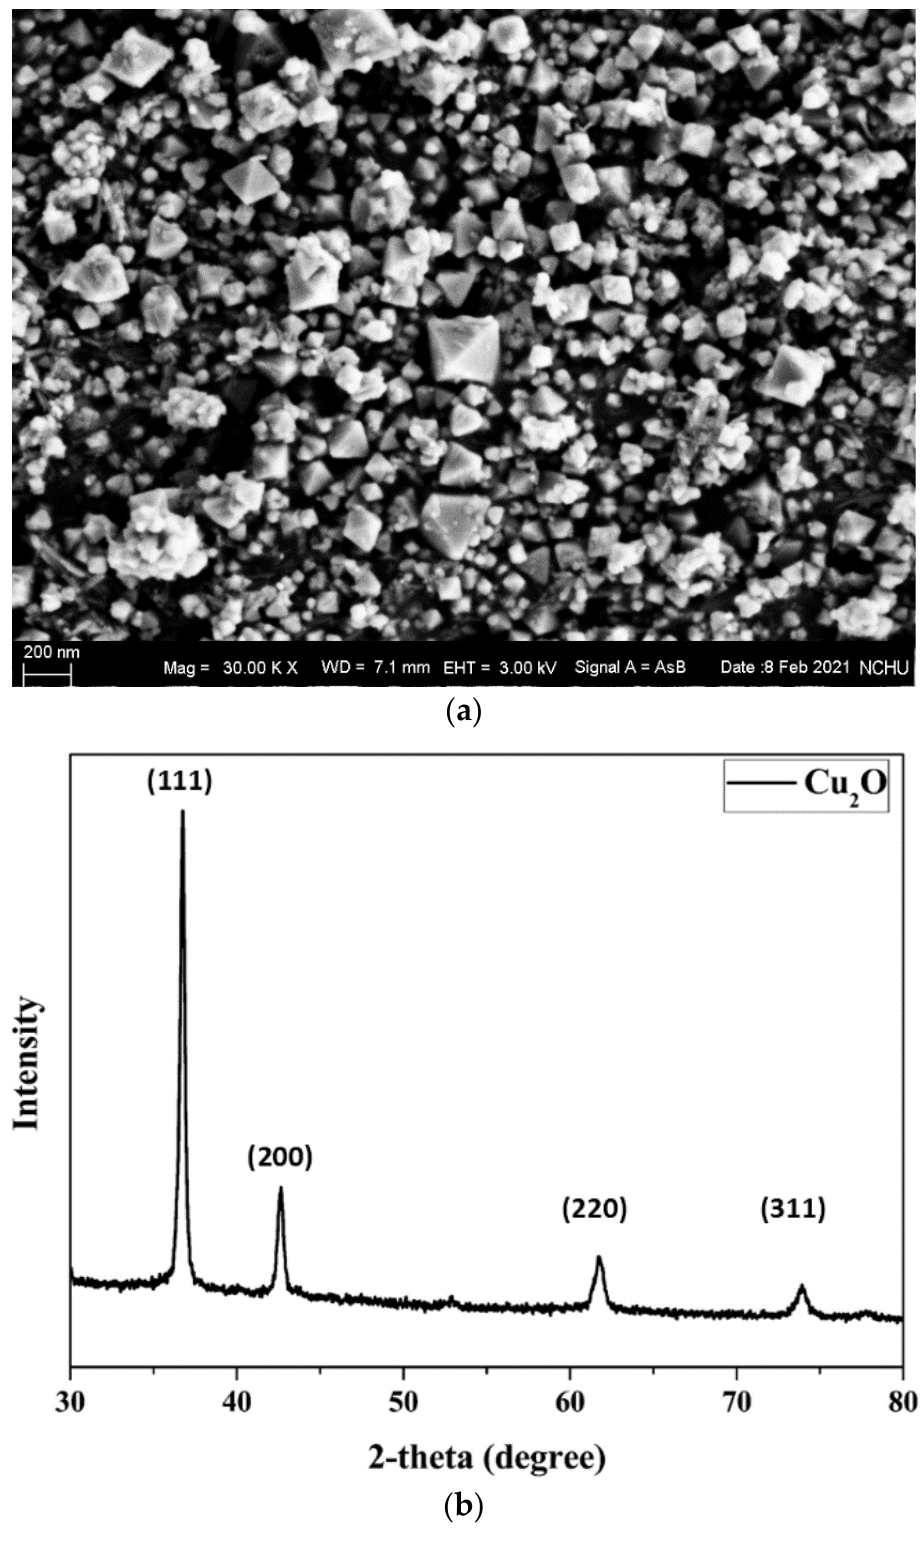
Figure 2. Cuprous oxide nanoparticles: ( a ) SEM image, and ( b ) XRD pattern.